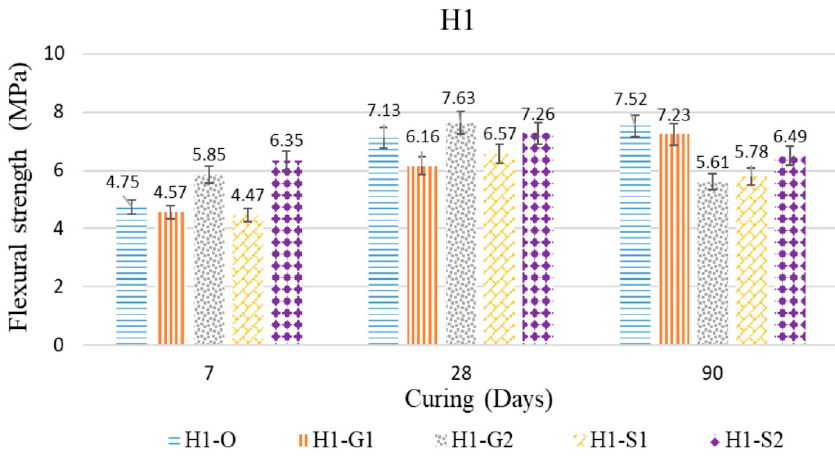
Figure 11. Flexural strength results for H1 high-strength pervious concrete specimens.